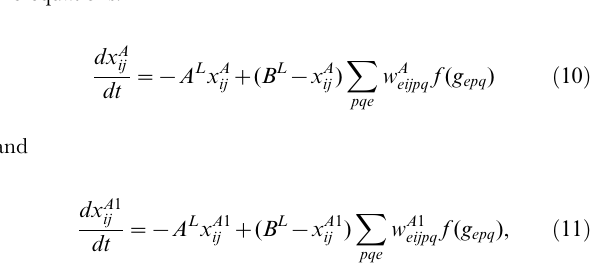
Table 1 for the parameters for the model retina.